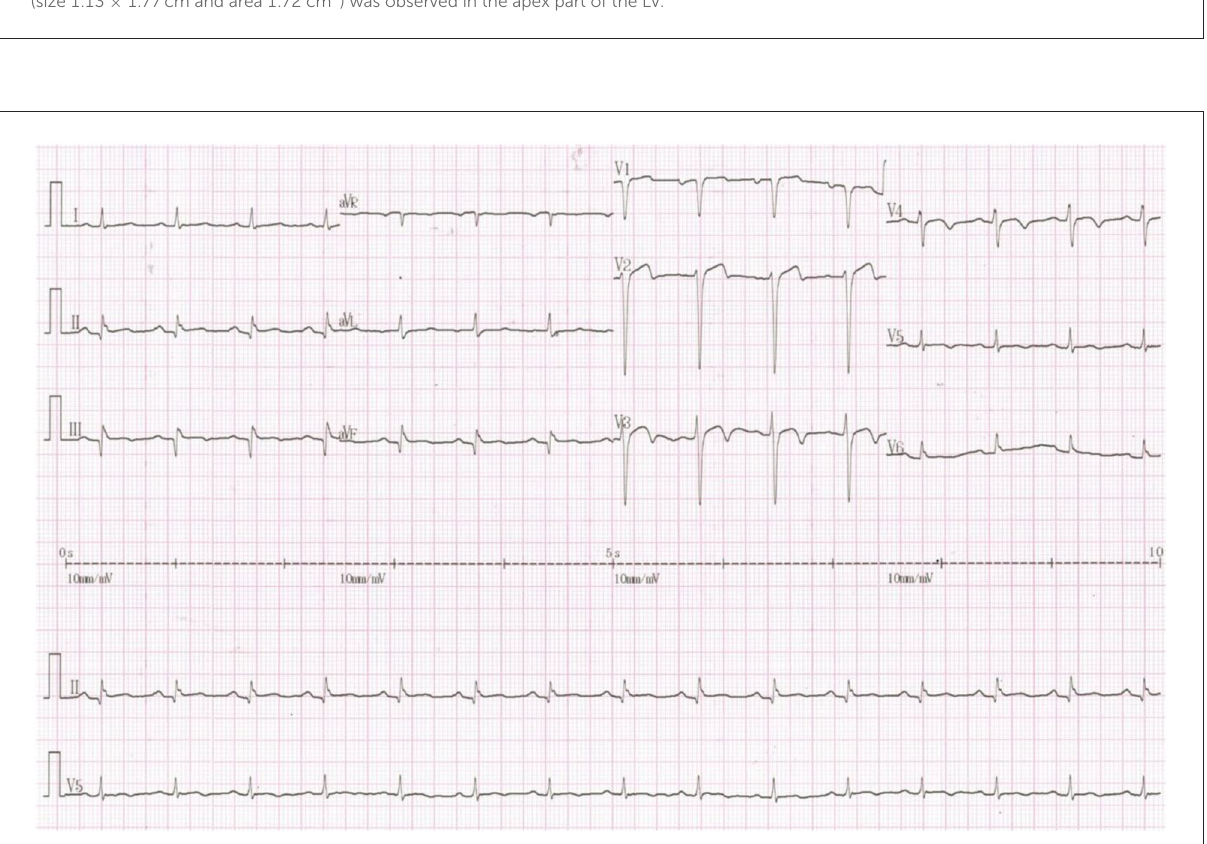
FIGURE2 Twelve-lead ECG findings on admission. The following ECG findings were observed: sinus rhythm; Q waves in the II, III, and aVF leads; the Q waves of the inspiratory phase became shallow but still existed; poor R-wave progression in chest leads; and T-wave inversion in leads V2 to